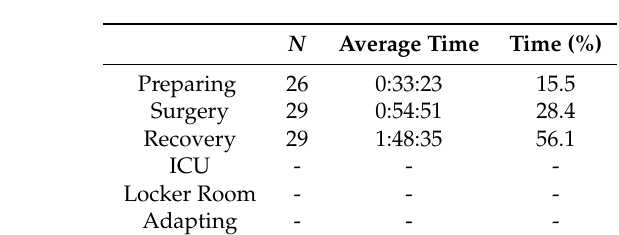
Figure 12. Process with other samples. Table 6. Other